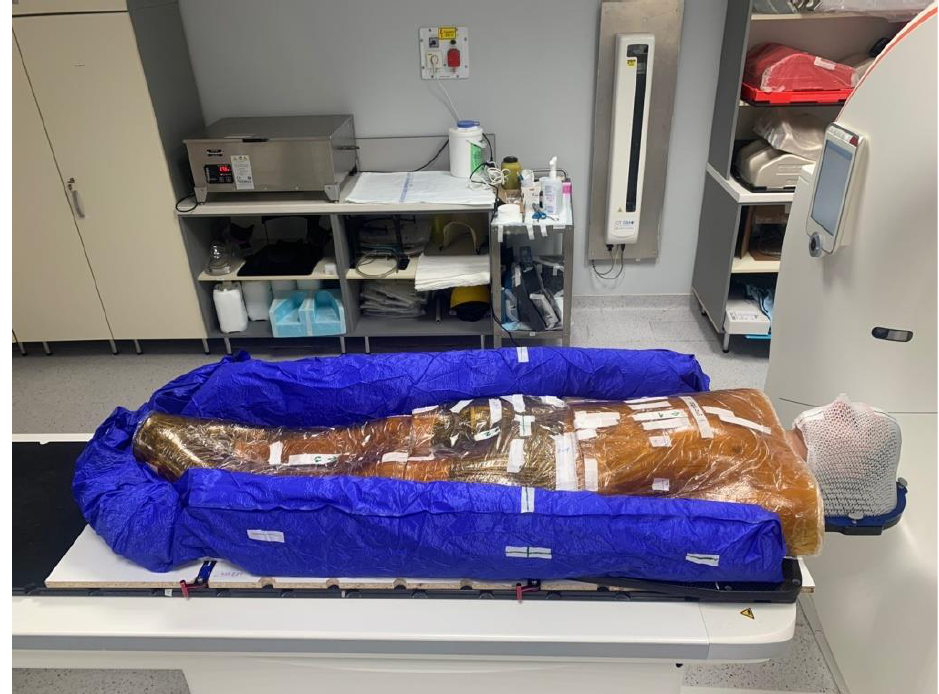
Figure 1. Patients need to be positioned in a reproducible position using a vacuum mattress, head fixation mask, full body bolus, and arrow signed post-its. The reference point is located at mid hip level.